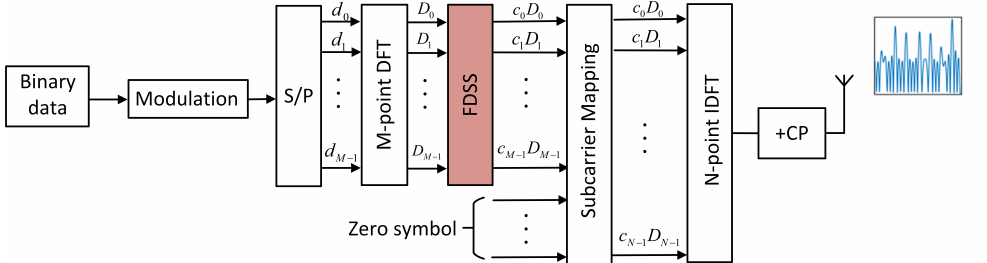
Figure 6. A DFT-s-OFDM transmitter model with a special FDSS